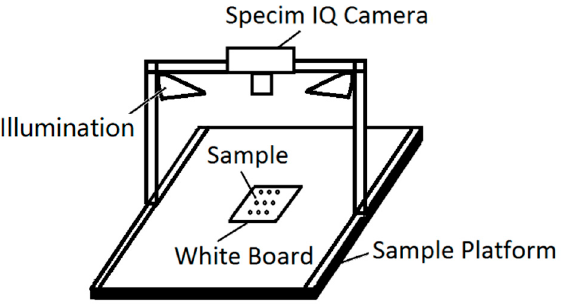
Figure 1. Schematic of the hyperspectral imaging system for rice seeds.